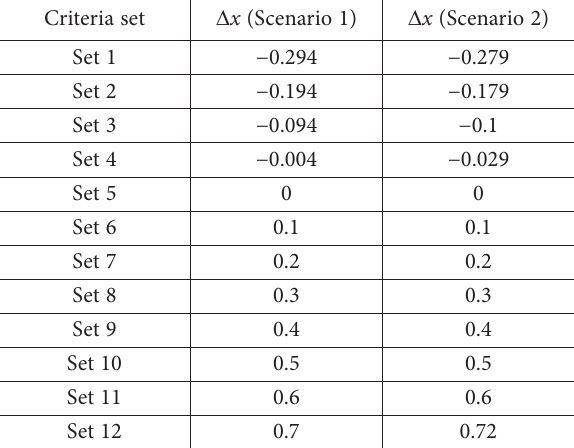
Table 15. The limiting bounds of the weight change ( ∆ x ) for both scenarios